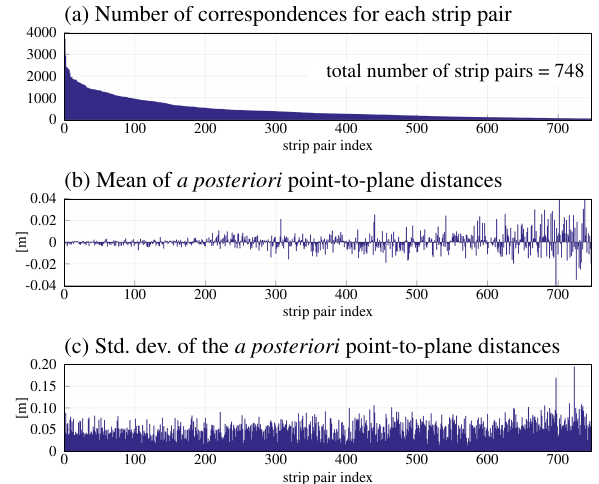
Figure 7: Strip adjustment results for all 748 overlapping strips pairs. The strip pairs are ordered according to the no. of corre-